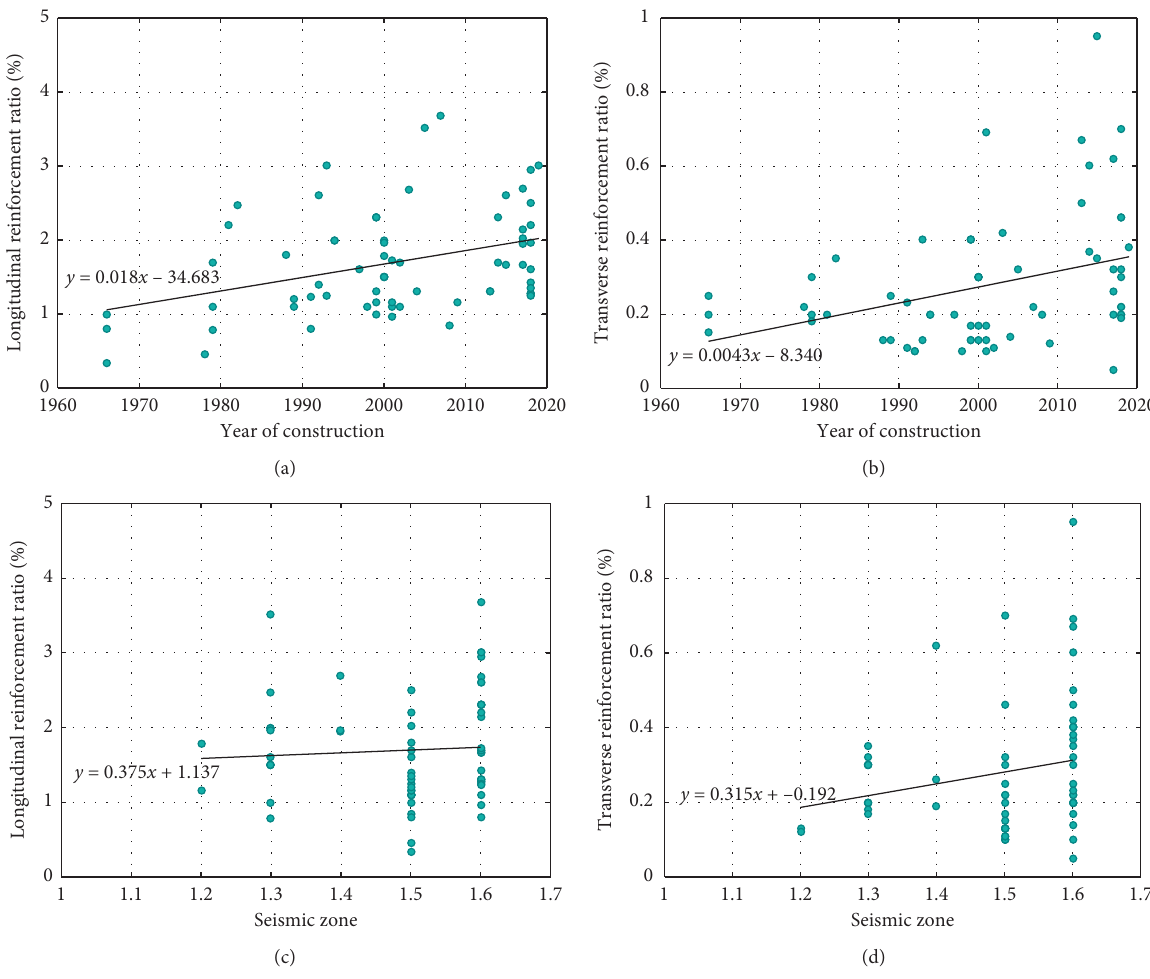
Figure 22: Evolution of (a) longitudinal reinforcement and (b) transverse reinforcement with the year of construction and evolution of (c) longitudinal reinforcement and (d) transverse reinforcement with the seismic zone.